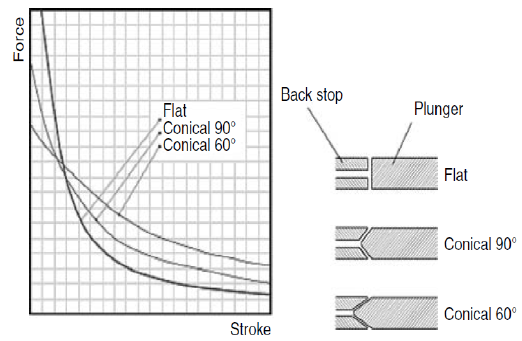
Figure 2 The generated magnetic force versus the plunger displacement for different plunger and stop designs [24].